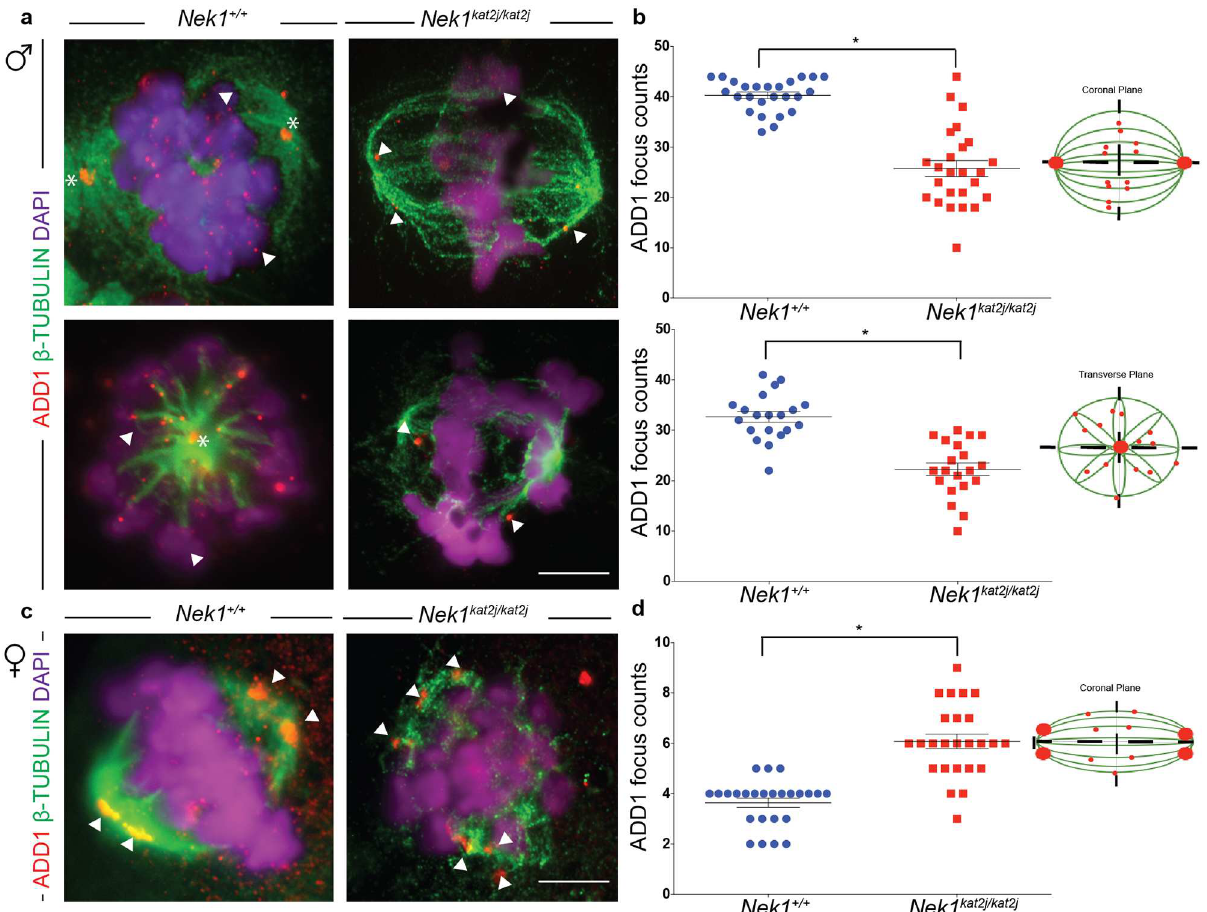
Fig 5. Nek1 kat2j/kat2j spermatocytes and oocytes show aberrantlocalization of Adducin 1 (ADD1)on meiosis I spindles. (a) IF against ADD1 (red), β -tubulin(green)and DAPI (magenta) on spermatocytes from wildtype(left) and Nek1 kat2j/kat2j mice (right) in coronal (top) and transverse (bottom) planes.Arrowheadsindicateexamplesof ADD1 foci. Quantitationof ADD1 focus counts per nucleus are given in panel (b). (c) IF against ADD1 (red), β -tubulin(green)and DAPI (magenta) in oocytes of both wildtypeand mutant mice. Arrowheads indicate examplesof ADD1 foci. Quantitation of ADD1 focus counts per nucleusare given in panel (d). All values are focus counts per spindleand black bars denote means ± Standarddeviation. * Indicates statistically significantdifferences (Unpaired t test p <